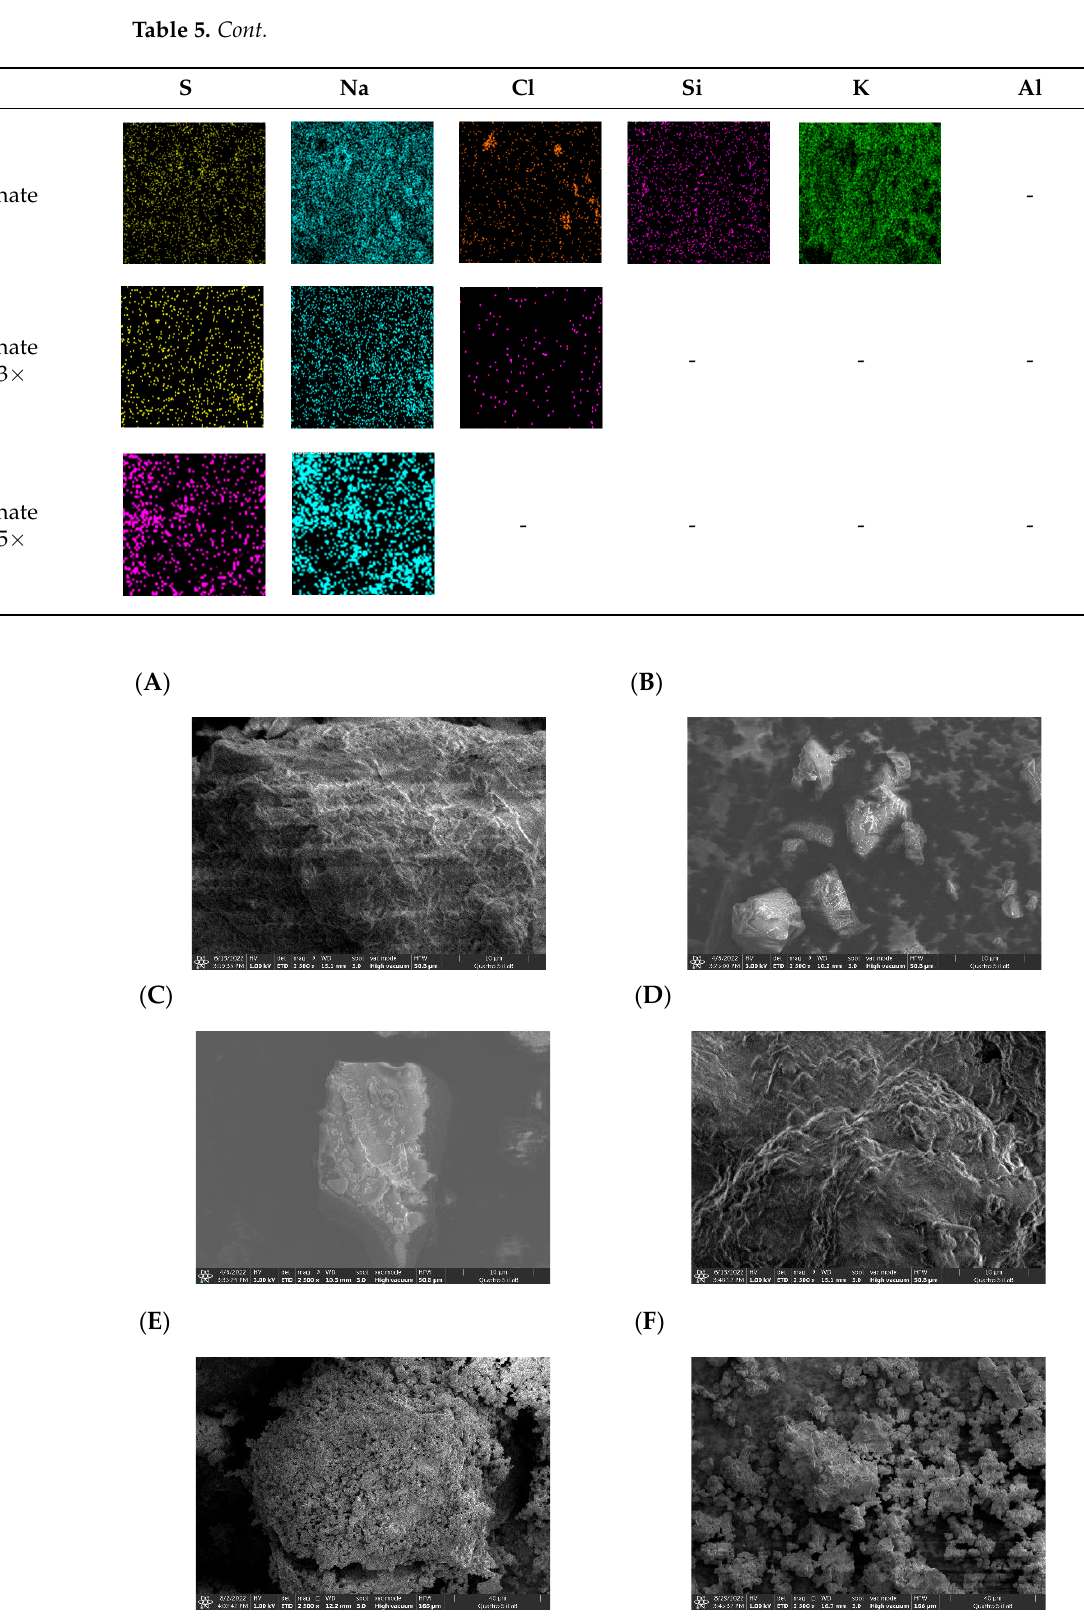
Figure 7. FESEM analysis on lignin reference ( A ), Eucalyptus 3× ( B ) and 5× ( C ) washing treatment; lignosulphonates reference ( D ), Eucalyptus 3× ( E ) and 5× ( F ) washing treatment. The DBE numbers of the Eucalyptus lignin after 3× and 5× washing treatments were also comparable with a value of 55.56 and 55.11, respectively. The DBE values of isolated lignin are similar to that of the reference lignin. The DBE values for the lignosulphonate Eucalyptus with 3× and 5× washing treatment were 33.53 and 30.37, respectively. Compared to the DBE of lignin, the DBE of lignosulfonate is lower. It is suggested that some OH groups in the aromatic structure of lignin are replaced by SO 3 H in electrophilic aromatic substitution. This significant difference in DBE also shows structural changes in molecules by sulfonation of lignin into lignosulfonate. However, washing did not change the structure of the lignin, as evidenced by similar DBE between lignin washed 3× and 5×. A similar statement has been reported by Hermiati et al. [33]. Ultimate analysis (Table 7) shows the presence of N element, a protein-lignin complex that might be formed during the pulping process [91] and its existence in the lignin indicated that isolation and washing treatment cannot remove the N element. The amount of N in the lignosulfonate increased dramatically, indicating that N was tightly bound to the lignin molecules as a protein-lignin complex and could not be lost during sulfonation. The lignin washing treatment has the potential to reduce contaminants. Sodium metabisulfite converts lignin into lignosulphonates, raising the elemental content of S for both lignosulphonates. In contrast, sodium hydroxide elevates the solution’s pH to 7 to produce the elemental content of Na. Ultimate analysis (Table 7) presents the empirical formula of lignin and lignosulfonate that is deducted from the elemental component in the samples. Eucalyptus lignin after 3× and 5× washing treatment has a relatively similar formula because of the non-significant difference in the content of C, H, N, and O in lignins. This formula is also similar to the reference lignin indicating that the isolation process successfully produced lignin with a similar structure. The computation was carried out similarly for H and O, producing a chemical formula for lignin (C 9 H x O y ) [92].